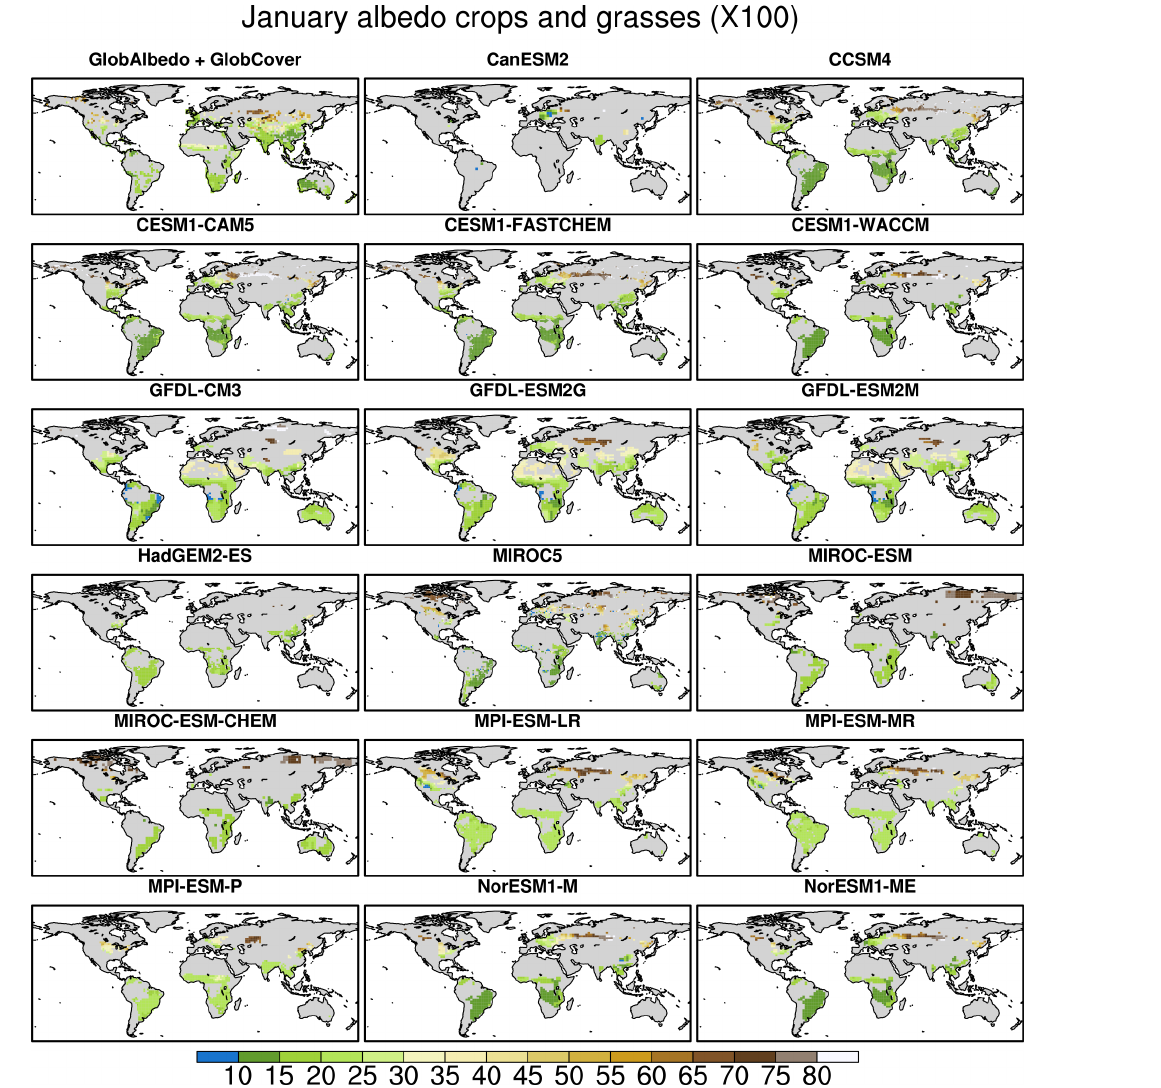
Figure 9. Same as Fig. 8, but for the month of January. Note that the scale is